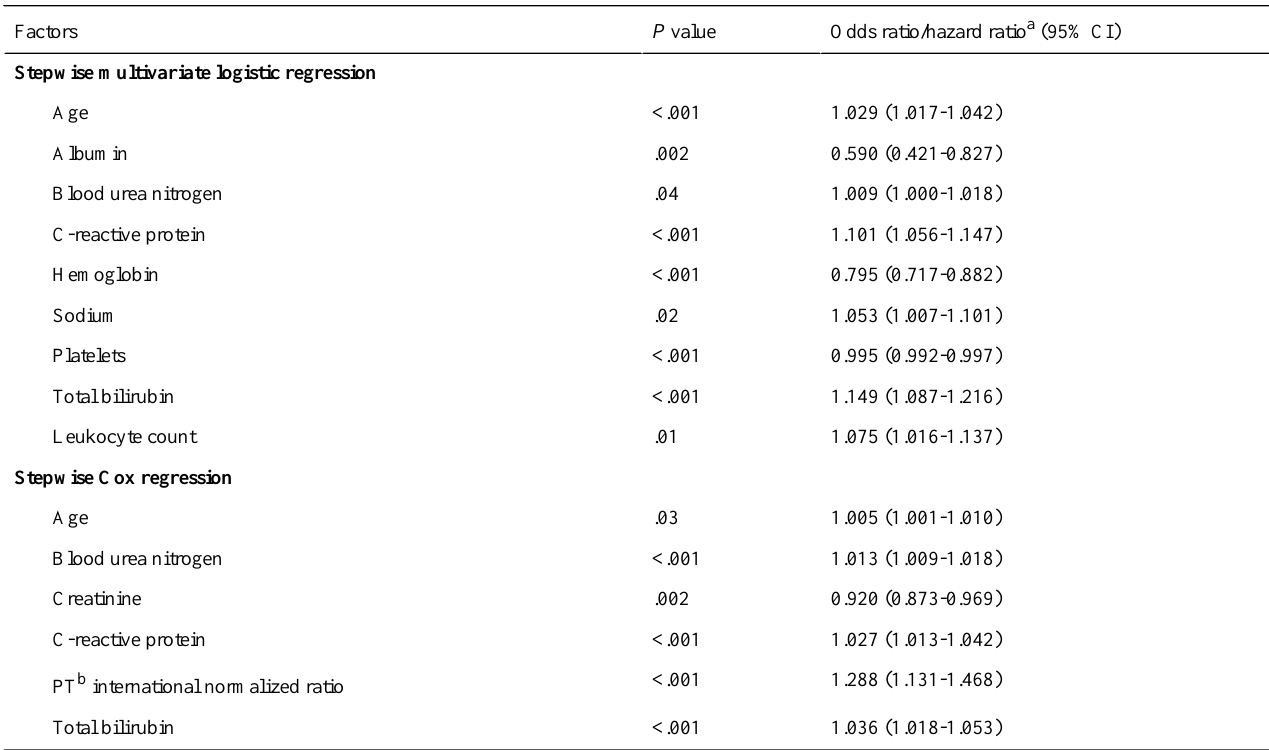
Table 4. Significant factors in stepwise multivariate logistic and Cox regression analyses.